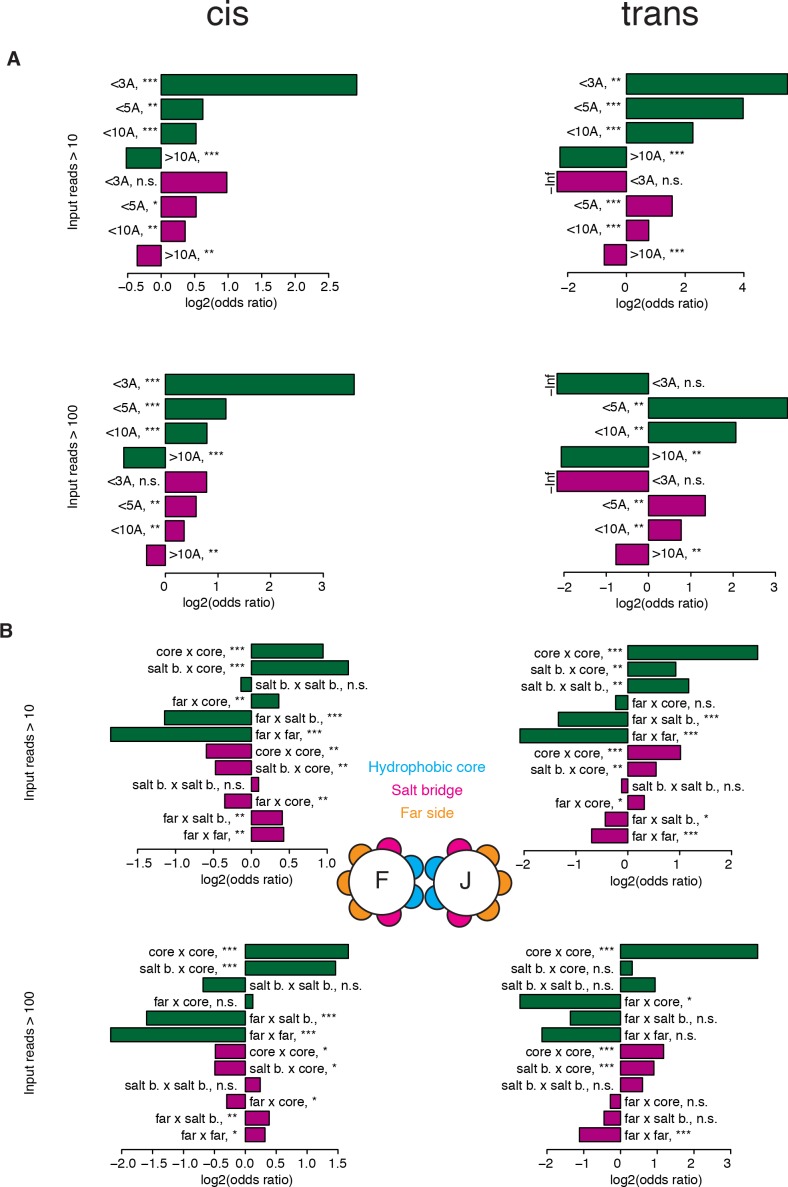
Comparisons of the patterns of structural genetic interactions in cis and trans.(A–B) Enrichment (Fisher’s exact test) for strong positive (green) or negative (purple) genetic interactions at different distance thresholds between the two mutated positions (A) and between different position types (B). These enrichments were also calculated after filtering out variants with 100 or less reads in any of the replicates input (bottom barplots on both panels), showing that the trends are the same even though the significance is lower with the stringent filter due to the smaller size of the dataset, especially for the trans library. The trans data analyzed here is restricted to amino acid substitutions reachable through single nucleotide changes. n = 17,290 and 14,118 for cis and trans, respectively, when filtering at 10 input reads, and 15,198 and 2,807, respectively, when filtering at 100 input reads. *, FDR < 0.1. **, FDR < 0.01. ***, FDR < 0.001. n.s., non significant.